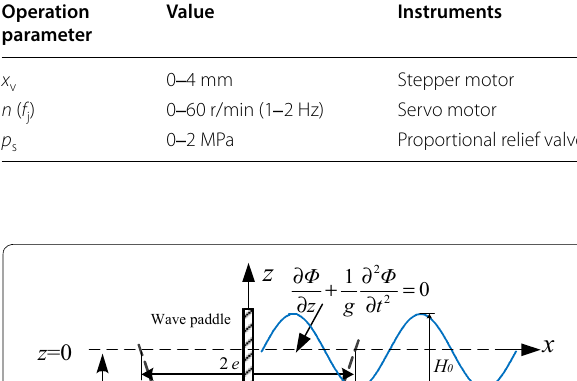
Table 3 Operation parameters with instruments Operation parameter